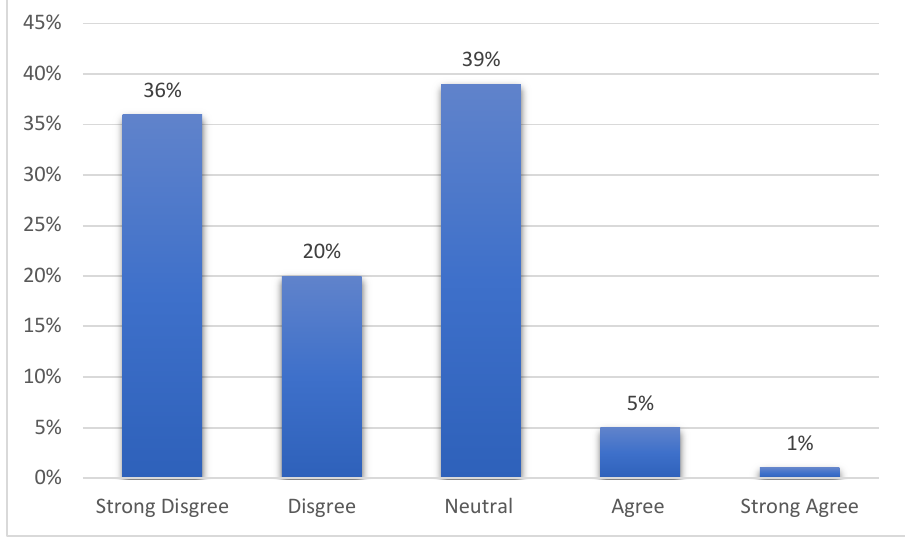
Figure 2: Ambulance’s adequacy